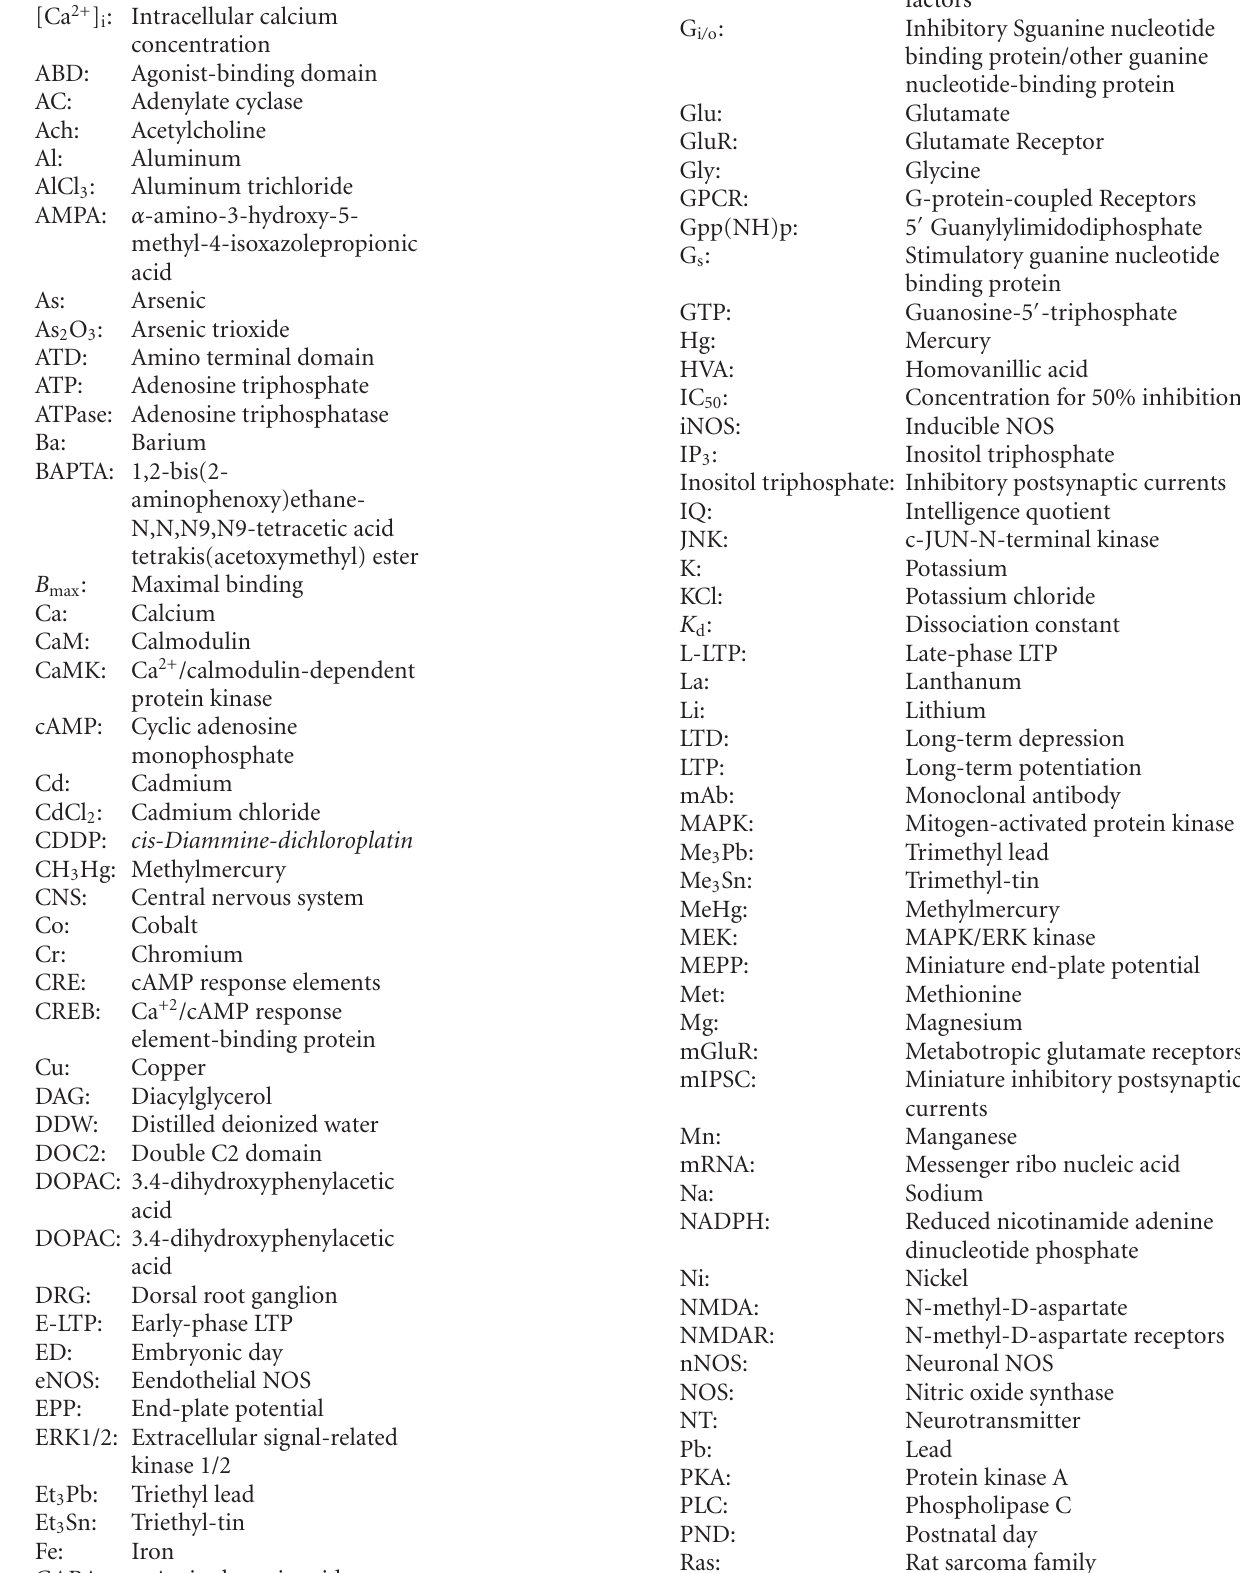
RBC: Red blood cells Sn: